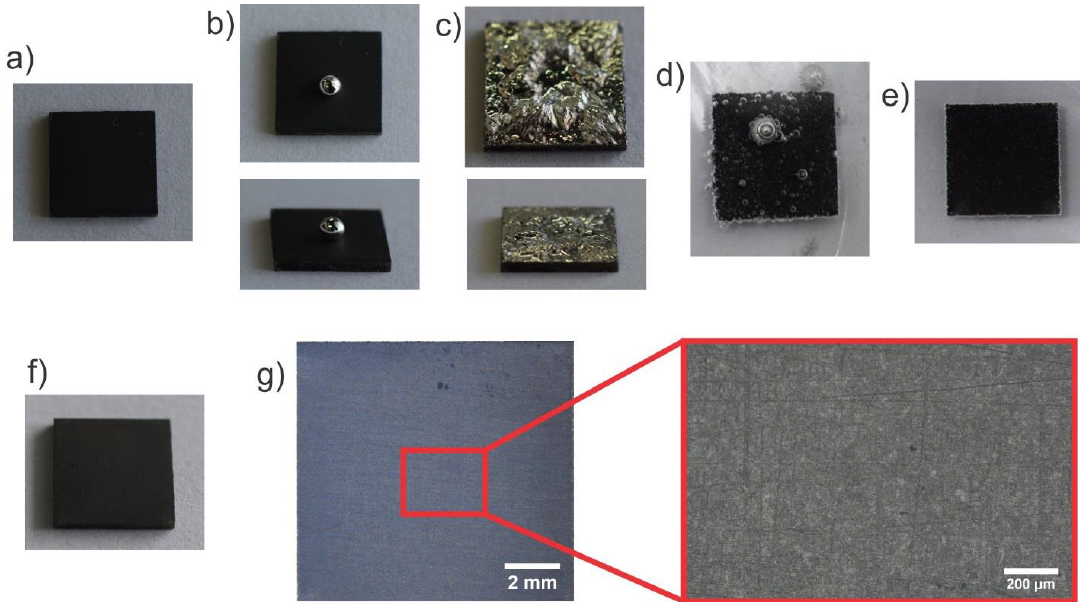
Figure 4. Application of the effect of adhesion of LM to diamond by repeated deposition and gentle force (massaging). The sample size is 10 mm × 10 mm. ( a ) Oxidized rough diamond coating (on Ti alloy) before liquid metal deposition. ( b ) Top and side view of a liquid metal deposited on the diamond coating, showing a high contact angle. ( c ) Optical image of the diamond coating with adhering liquid metal by applying the repeated deposition and massaging approach. ( d ) Removal of the liquid metal (oxide) from the surface of the diamond-coated Ti alloy by immersion in 1 mol/L H2SO4 solution. The liquid metal beads up due to removal of the oxide skin. ( e ) Second removal step in sulfuric acid. ( f ) Substrate after liquid metal removal with sulfuric acid and gentle rubbing with ethanol. ( g ) Optical microscopy images of the cleaned diamond coatings, signifying a clean and undamaged